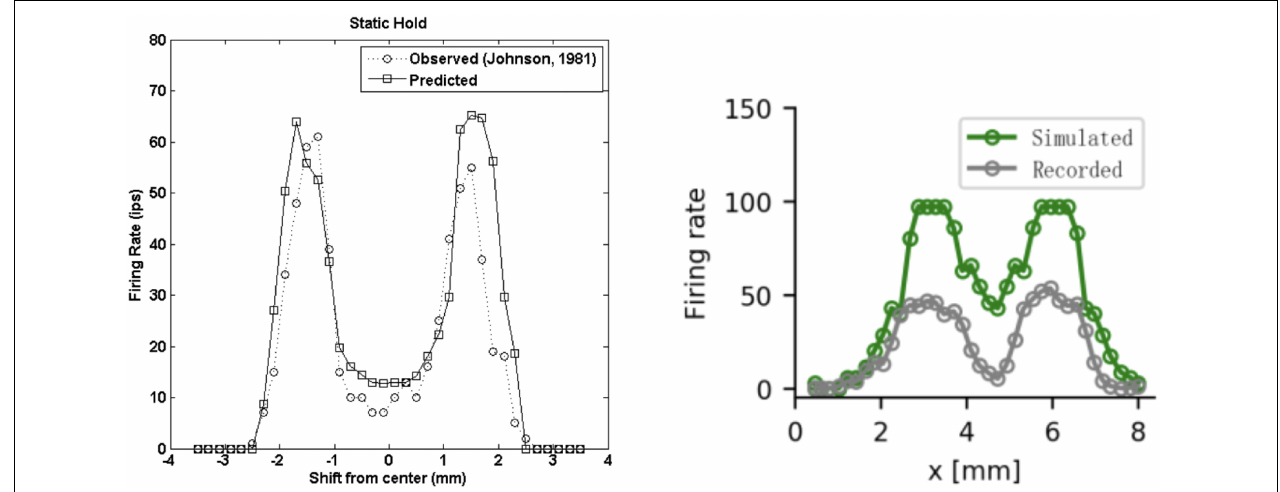
FIGURE 7 | Firing rates during the static phase of the response to a 3 mm wide edge indented 1 mm. (Left) Recorded (dotted line, Phillips and Johnson, 1981a) and predicted (solid line, Gerling et al., 2013) SA1 firing rates as a function of the location with respect to the stimulus. Note the x -axis is different in the two graphs. (Right) Recorded (gray, Ouyang et al., 2021) and predicted (green, Phillips and Johnson, 1981a) SA1 firing rates as a function of the location with respect to the stimulus. Left image from Gerling et al. (2013). Right image from Ouyang et al. (2021). (Right) Republished with permission of The Institute of Electrical and Electronics Engineers, Incorporated (IEEE), from Ouyang et al. (2021); permission conveyed through Copyright Clearance Center, Inc. (Left) Republished with permission of The Institute of Electrical and Electronics Engineers, Incorporated (IEEE), from Gerling et al. (2013); permission conveyed through Copyright Clearance Center,